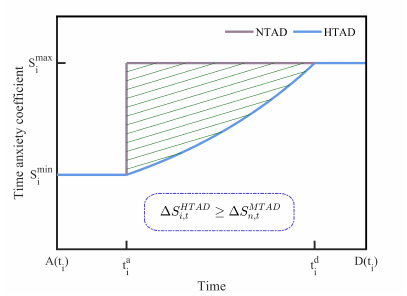
Figure 5. The time anxiety impact of